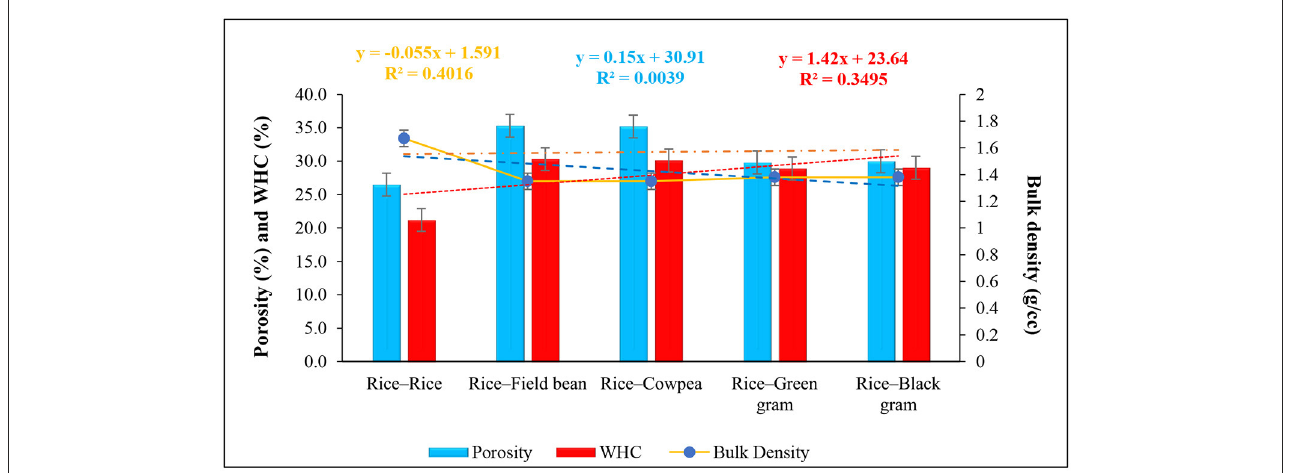
FIGURE5 Inclusion of pulses in rotation significantly improved soil porosity ( y = 0.15x + 30.91; R 2 = 0.0039 ), water holding capacity ( y = 1.42x + 23.64; R 2 = 0.3495 ), and reduced bulk density ( y = − 0.055x + 1.591; R 2 = 0.4016 ). The rice–field bean (33.21, 42.92, and − 19.16%), rice–cowpea (32.83, 41.98, and − 19.16%), rice–mung bean (12.45, 36.32, and − 17.37%), and rice–urd bean (13.21, 36.79, and − 17.37%) improved porosity, WHC and bulk density, respectively over the mono-cropping of rice–rice ( Date source : Prakash et al., 2008).